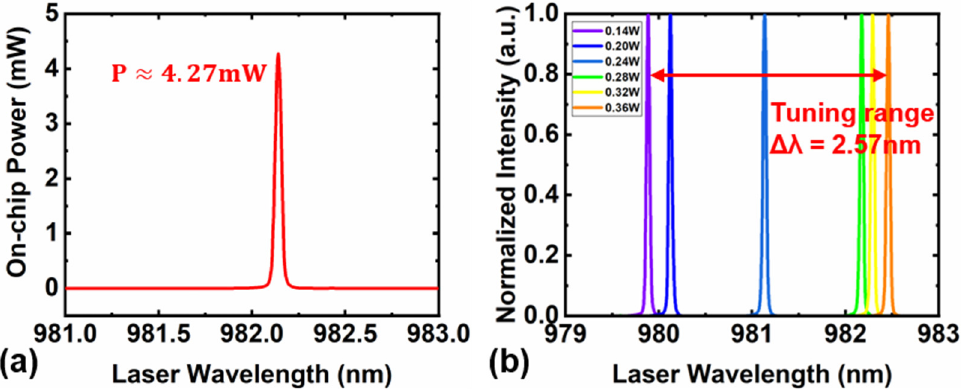
Figure 6. ( a ) Spectral power density of 980 nm narrow linewidth self-injected locking laser emission. ( b ) The dependence of the narrow linewidth laser wavelength on the applied electrical power.